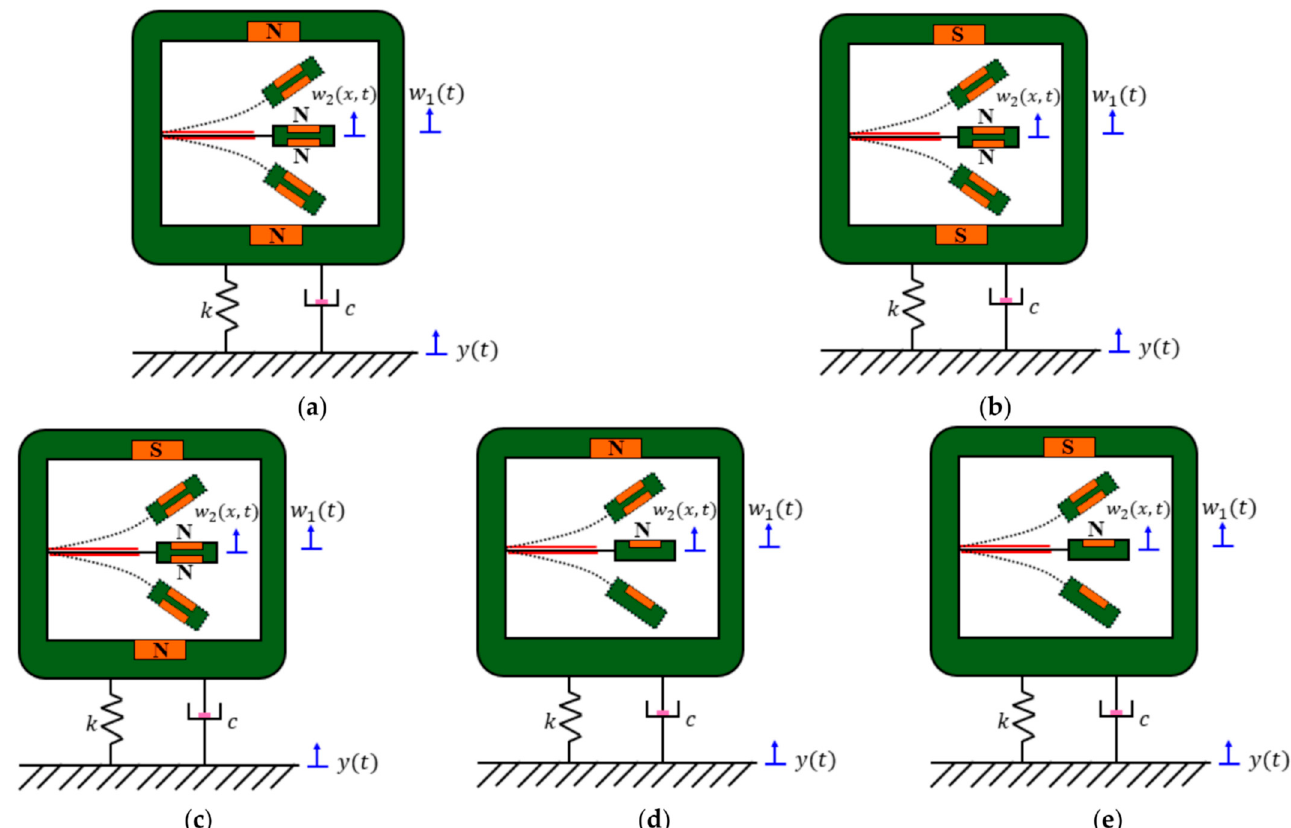
Figure 2. A representation of the coupled system under investigation with two magnet constraints with ( a ) repulsive and ( b ) attractive configurations that generate neutral static positions. The con- figurations that generate a change in static position are ( c ) two magnet constraints with opposite polarities and single magnet constraints of ( d ) repulsive and ( e ) attractive configurations [5].